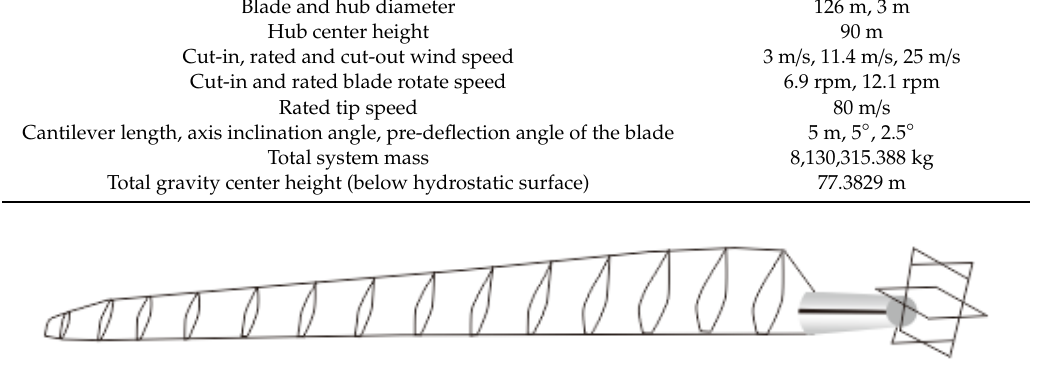
Figure 2. Blade structure of NREL 5 MW wind turbine.